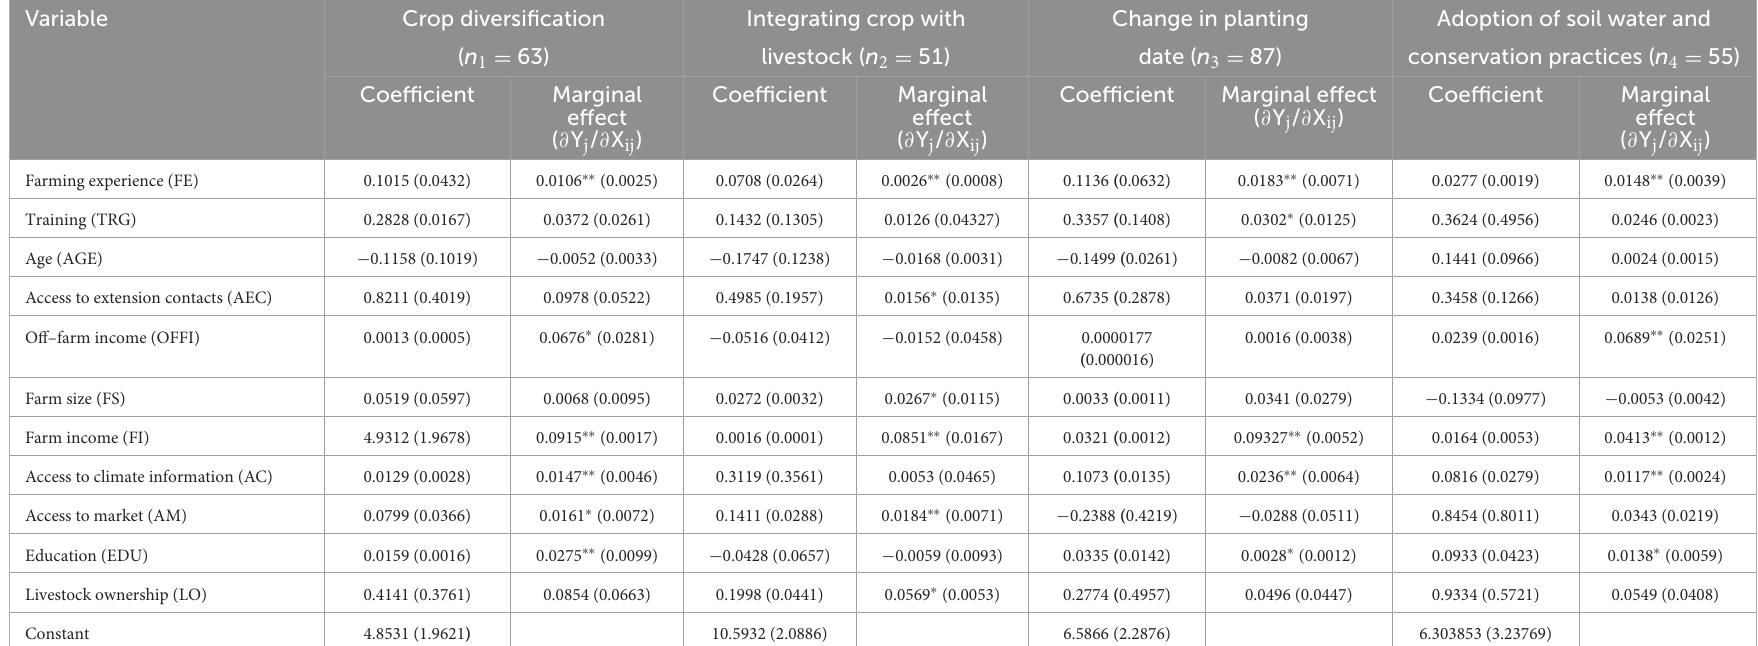
TABLE 9 Parameter estimates of multinomial logistic model for CCAS by sample